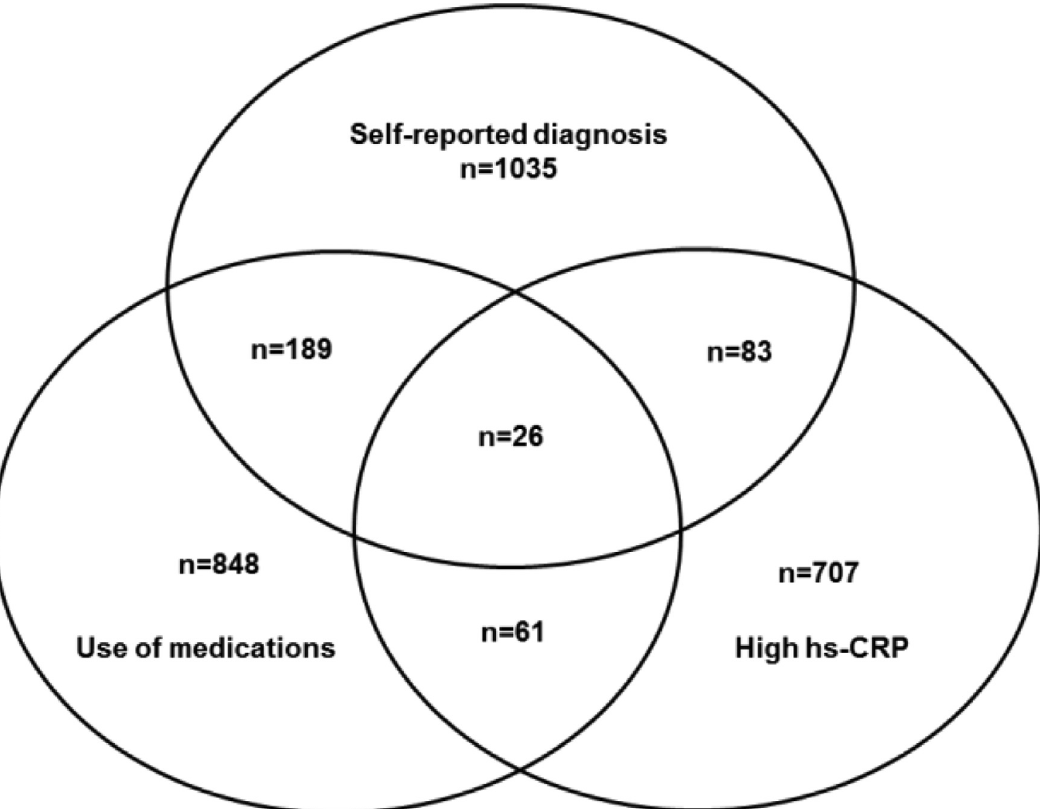
Figure 1. Venn diagram showing the selection of participants to the high-risk groups for chronic in fl ammatory diseases according to the number of